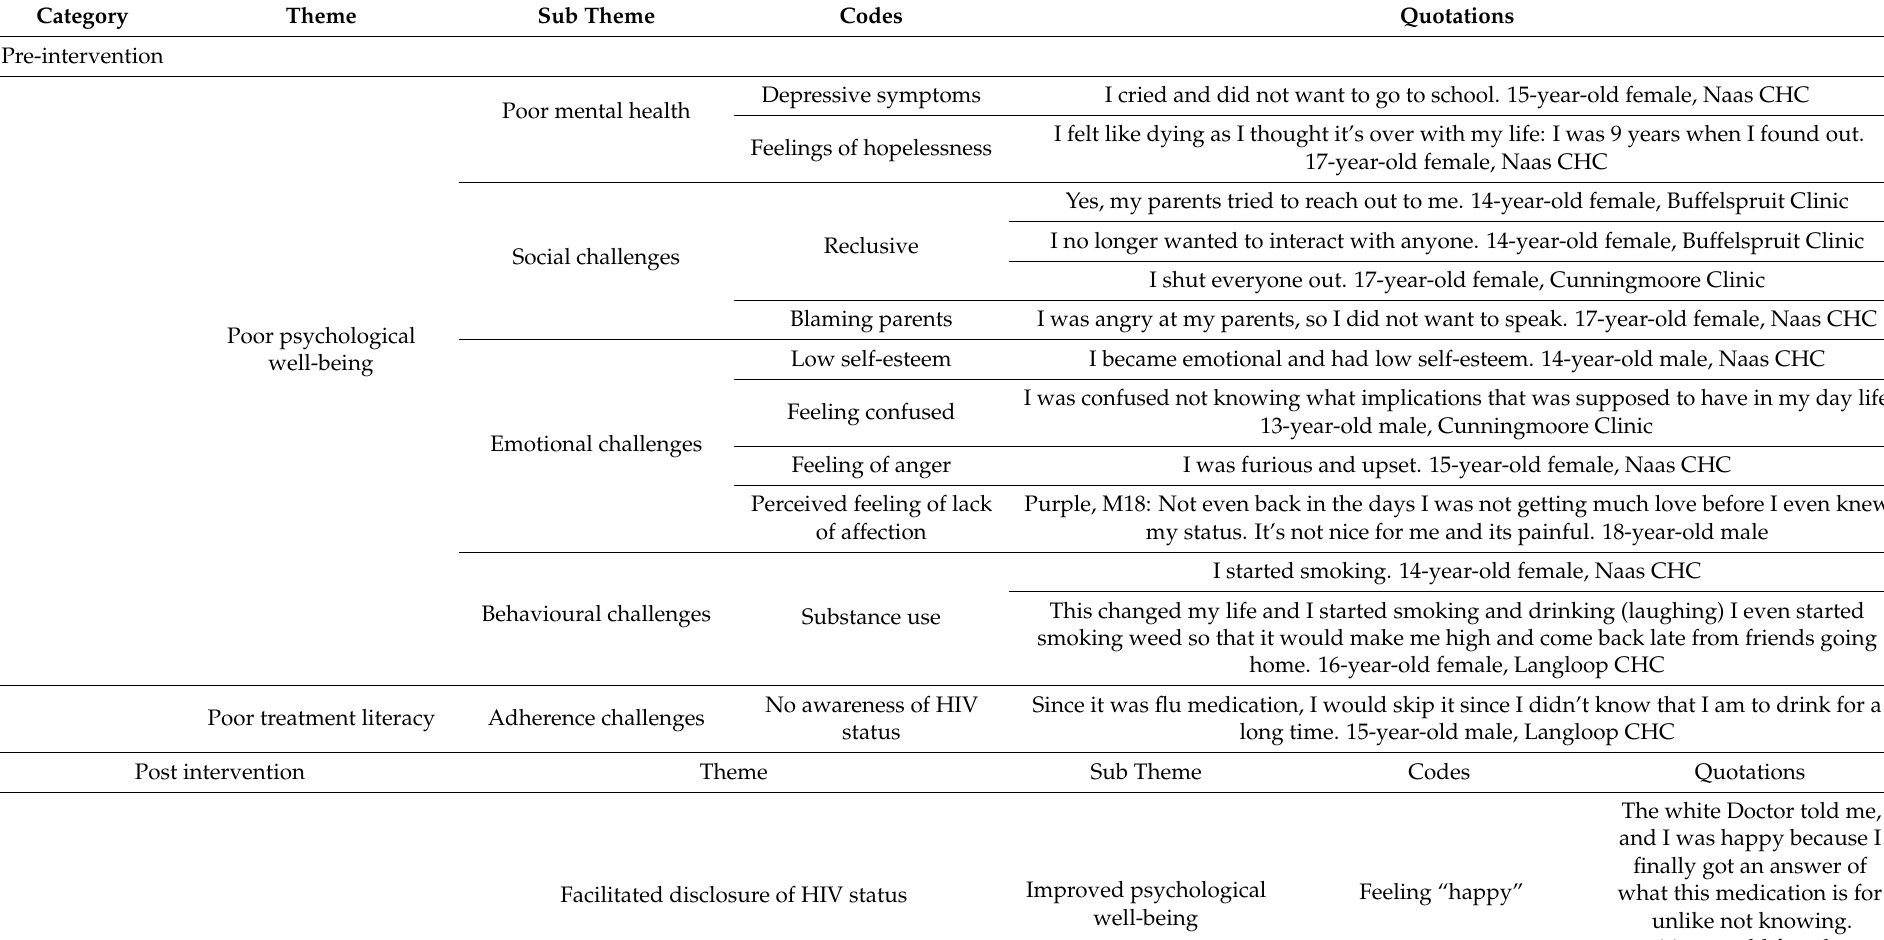
Table 1. Themes, subthemes, and codes by programme